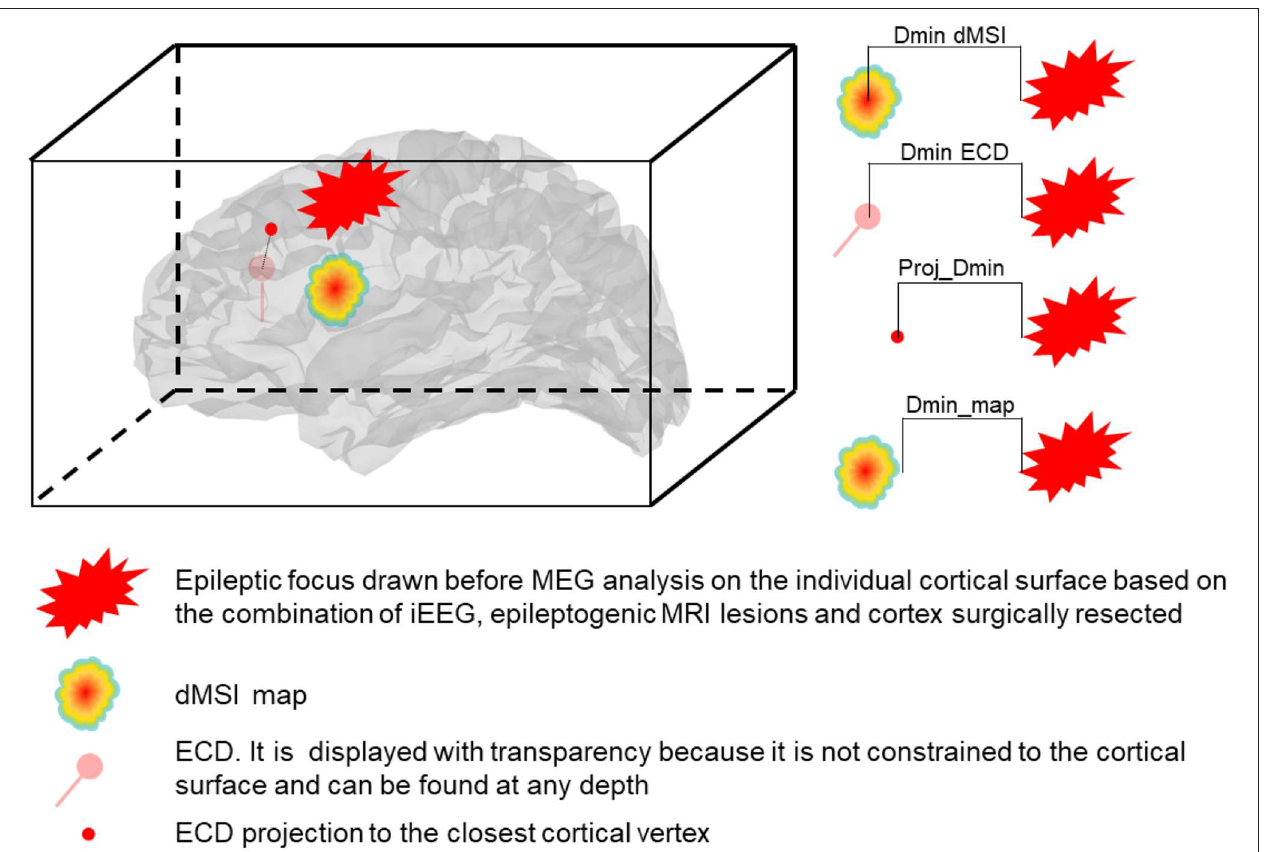
FIGURE 1 | Representation of the measures of accuracy. Dmin is the Euclidean distance expressed in mm between the source and the focus. Dmin dMSI is the distance between the maximum intensity (one single vertex) cortical map and the closest point of the focus. Dmin ECD is the distance between the ECD and the closest point of the focus. Proj_Dmin is the distance between the ECD projected to the closest cortical vertex and the closest point of the focus. Dmin_map is the distance between the border of the cortical map thresholded at 30% of the maximal intensity and the closest point of the focus.